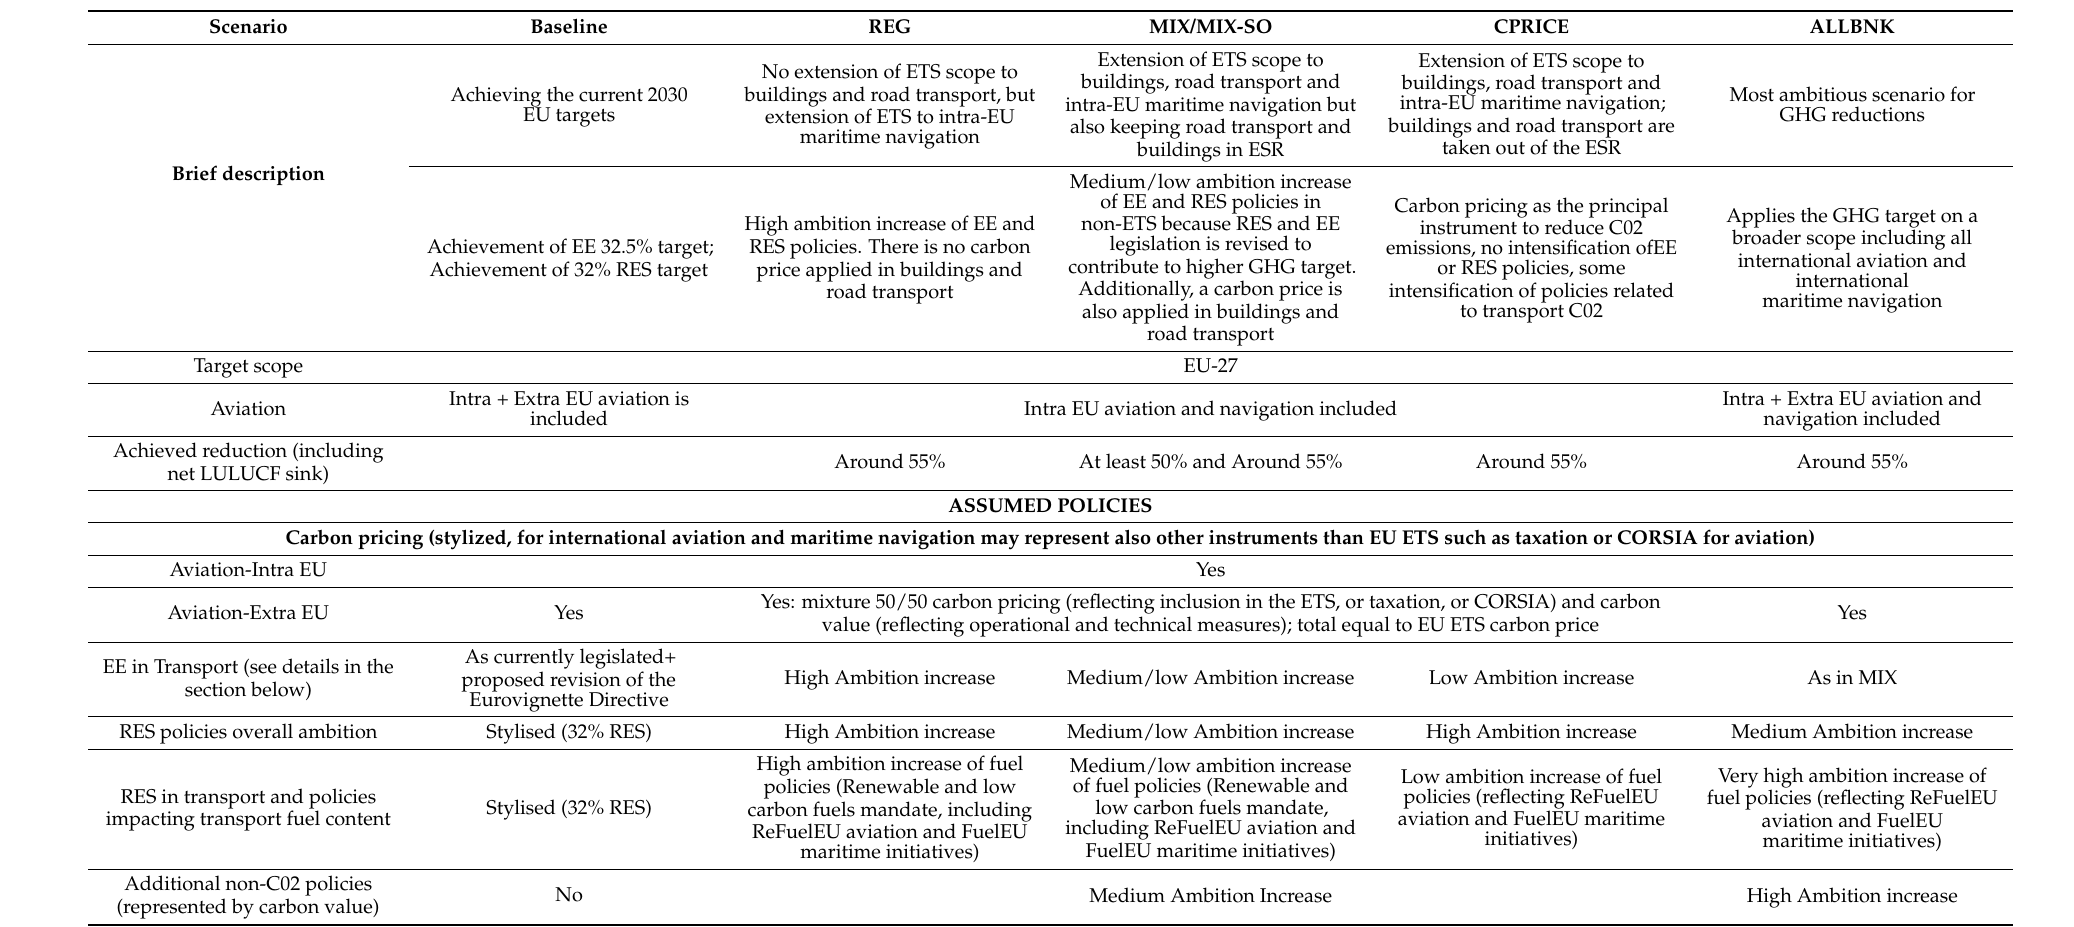
Table A5. Description of the assumptions underlying the Sustainable and Smart Mobility Strategy